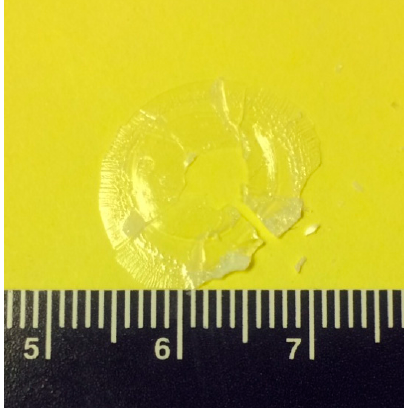
Figure 2. Photo of as-grown Ba 2 Zn(BO 3 ) 2 crystals. The minimum scale on the ruler is 1 mm.